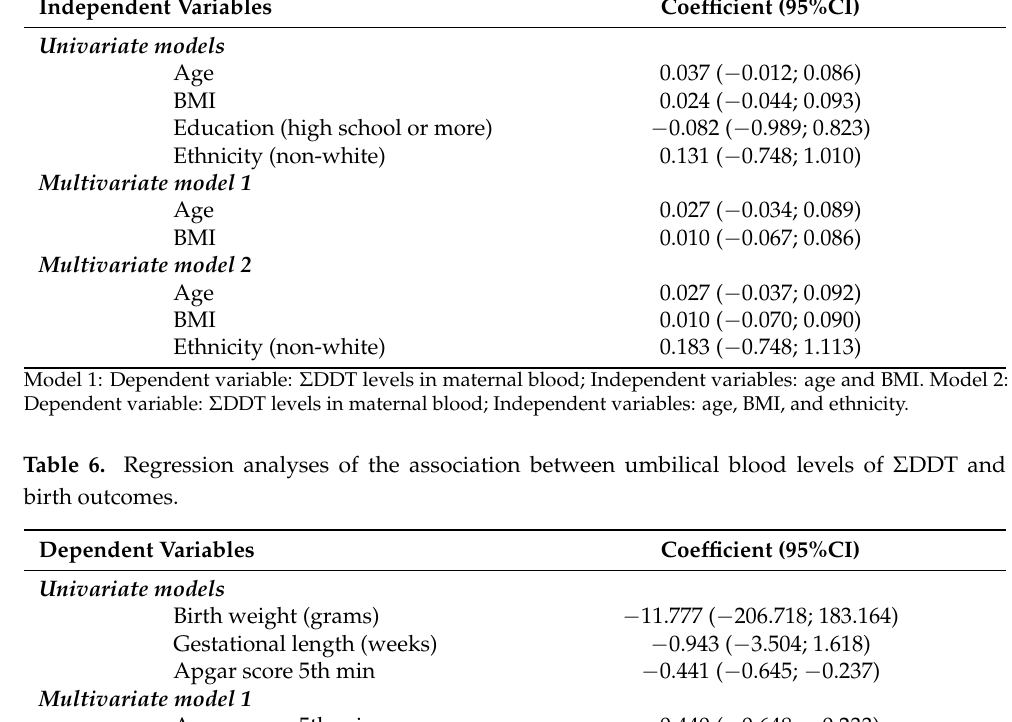
Table 5. Regression models for maternal blood levels of Σ DDT predictors. Independent Variables